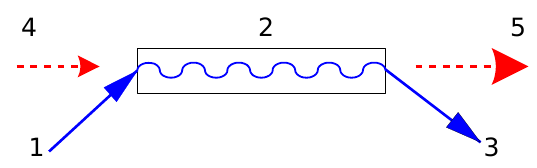
Fig. 1. The scheme of FEL amplifier: 1 – incoming electron beam, 2 – undulator, 3 – used electron beam, 4 – incoming electromagnetic wave, 5 – amplified electromagnetic